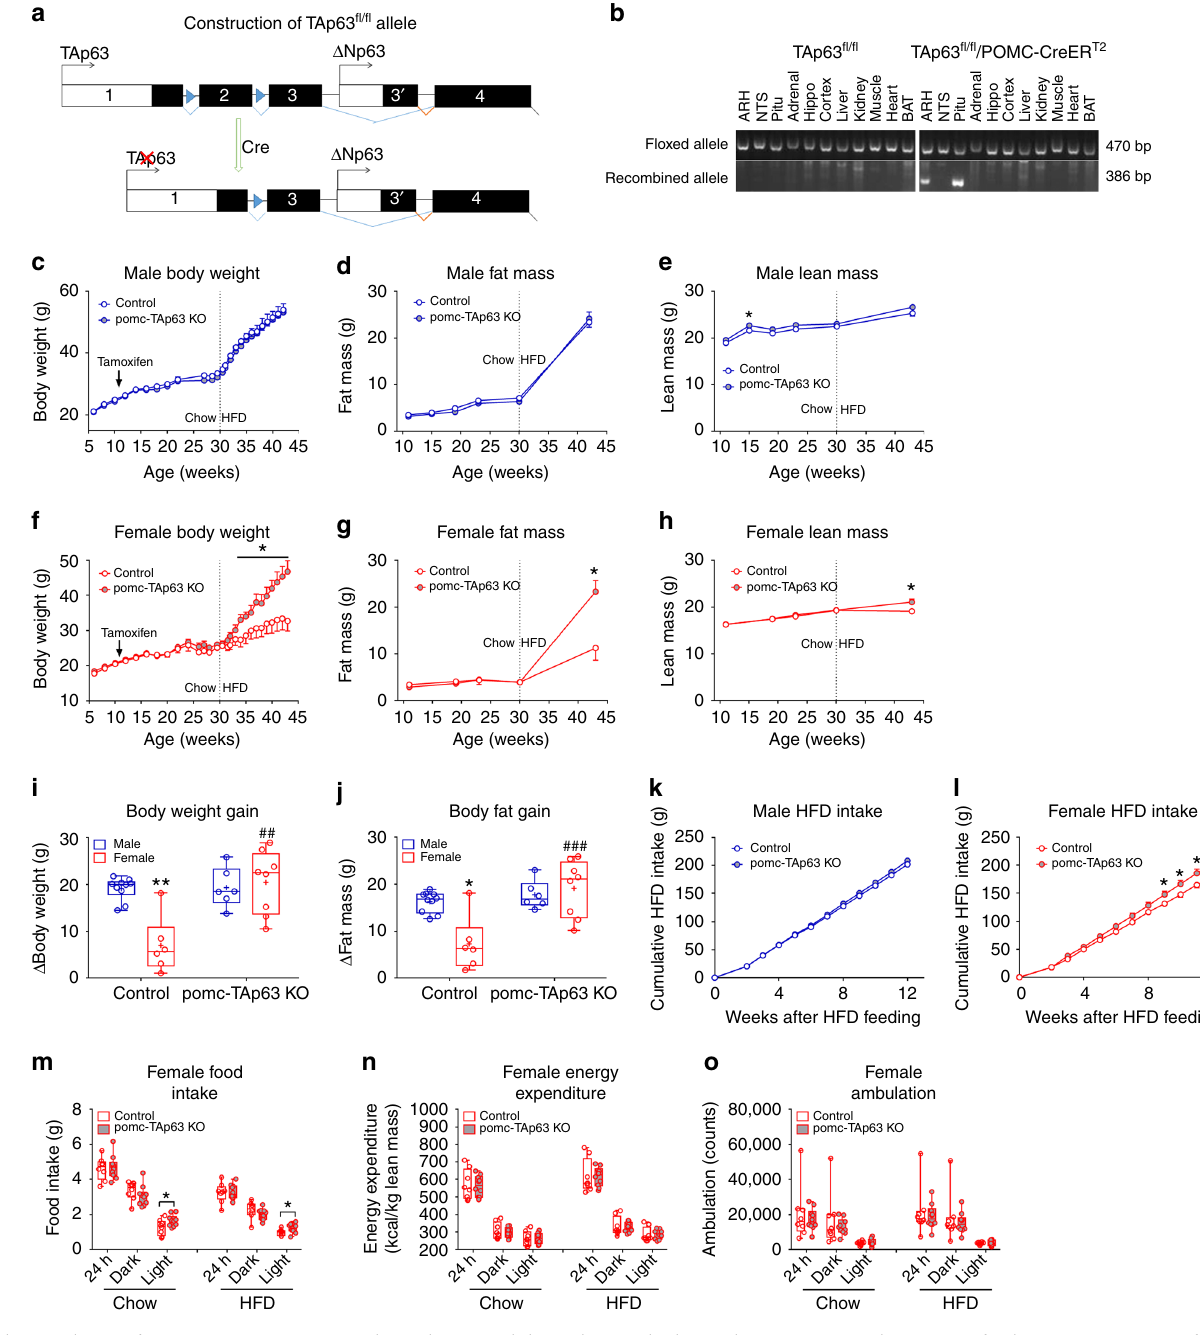
Fig. 3 Deletion of TAp63 in POMC neurons diminishes sexual dimorphism in body weight responses to chronic HFD feeding. a Construction of TAp fl / fl mouse allele. Two loxP sites fl ank exon 2 of the p63 gene and Cre-mediated recombination results in disruption of TAp63 expression; Δ Np63 expression starts from exon 3 and is therefore not affected by the recombination. b PCR detection of TAp fl / fl allele and Cre-induced recombination in various tissues from the control ( TAp63 fl / fl ) or the pomc-TAp63 KO ( TAp63 fl / fl /POMC-CreER T2 ) mice. Adrenal, adrenal gland; ARH, arcuate nucleus of the hypothalamus; BAT, brown adipose tissue; hippo, hippocampus; NTS, nucleus of the solitary tract; pitu, pituitary. c – e Body weight ( c ), fat mass ( d ), and lean mass ( e ) of male mice. Data are presented as mean ± SEM. N = 6 or 10 per group. * P < 0.05 in t -tests. f – h Body weight ( f ), fat mass ( g ), and lean mass ( h ) of female mice. Data are presented as mean ± SEM. N = 6 or 8 per group. * P < 0.05 in two-way ANOVA followed by post hoc Sidak tests. i – j Gains in body weight ( i ) and fat mass ( j ) during the 13-week HFD feeding. Data are presented as box and wiskers showing minimal, maximal, and median values with individual data points. N = 6 – 10 per group. * P < 0.05 or ** P < 0.01 between male vs. female with the same genotype; ## P < 0.01 or ### P < 0.001 between the two genotypes within the same sex in two-way ANOVA followed by post hoc Sidak tests. k – l Cumulative HFD intake in male ( k ) and female ( l ) mice during the 13-week HFD feeding. Data are presented as mean ± SEM. N = 6 or 10 per group. * P < 0.05 in two-way ANOVA followed by post hoc Sidak tests. m – o Female control and pomc-TAp63 KO littermates (30 weeks of age) were adapted into the CLAMS metabolic cages and subjected to a 3-day chow 3-day HFD feeding protocol. Food intake ( m ), energy expenditure (normalized to lean mass, ( n )), and ambulation ( o ) when fed chow or HFD. Data are presented as box and wiskers showing minimal, maximal, and median values with individual data points. N = 8 or 10 per group. * P < 0.05 between the two